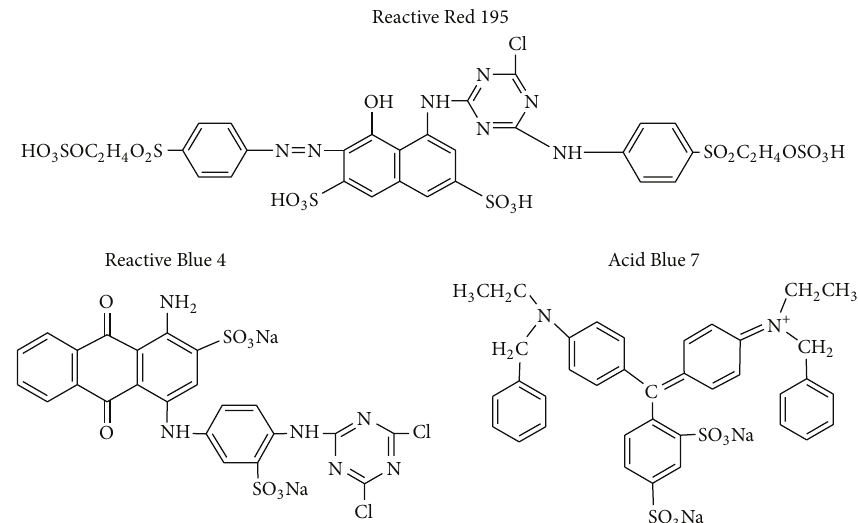
Figure 1: Chemical structures of the three dyes.